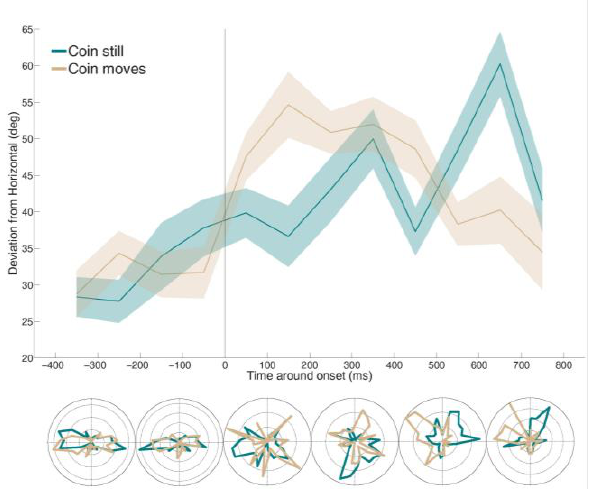
Figure 5. Average deviation from horizontal direction for microsaccades produced around the presentation of MTS stimuli. Polar histograms are shown in 200 ms intervals.